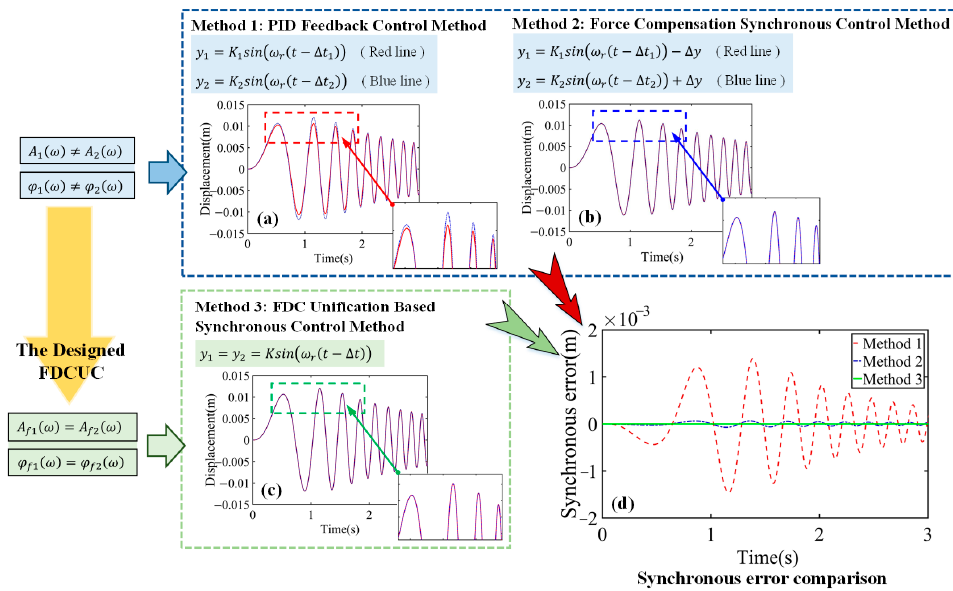
Figure 3. Working principle of the FDC-UM and comparison of synchronization errors with three different control methods: PID feedback method, force compensation method, and the proposed FDC-UM method.